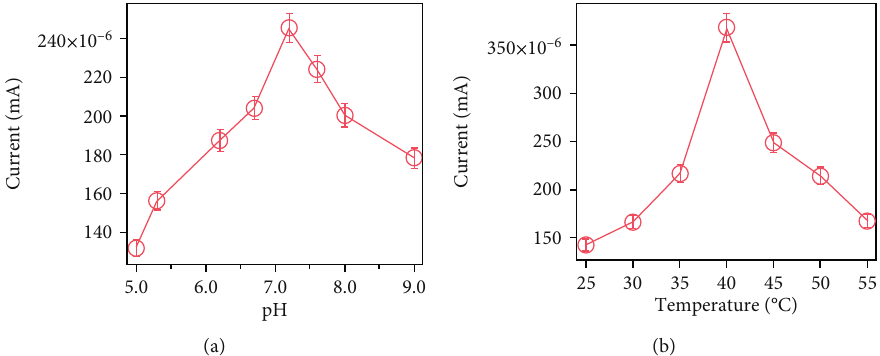
Figure 7: E ff ect of (a) pH and (b) temperature on the response of ChOx/CeO